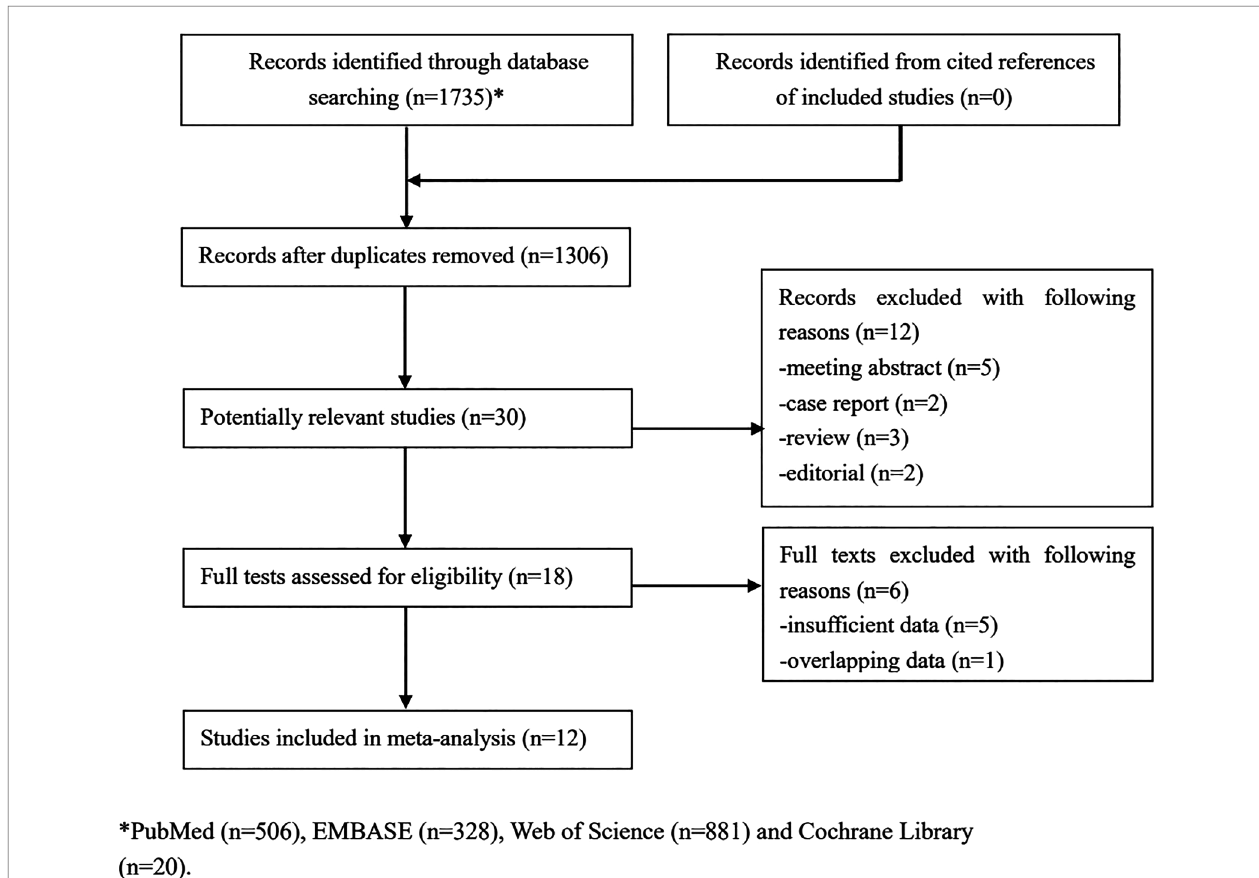
FIGURE 1 | The fl ow diagram of this